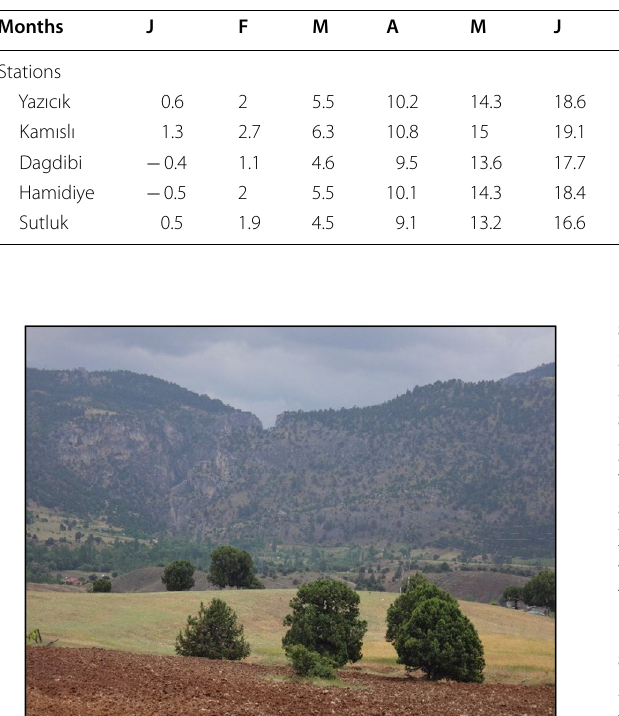
Table 2 Annual average temperature difference of stations in the study area Station and observation time data Latitudinal location Elevation (m) Annual avg.